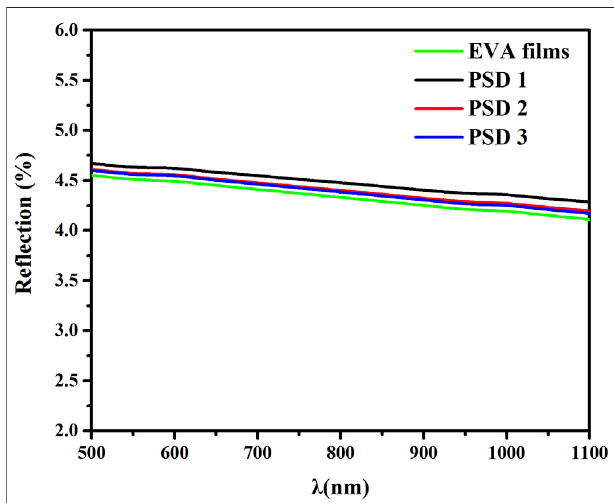
FIGURE 6 | Re fl ection of EVA fi lms with different particle size distributions of LDS